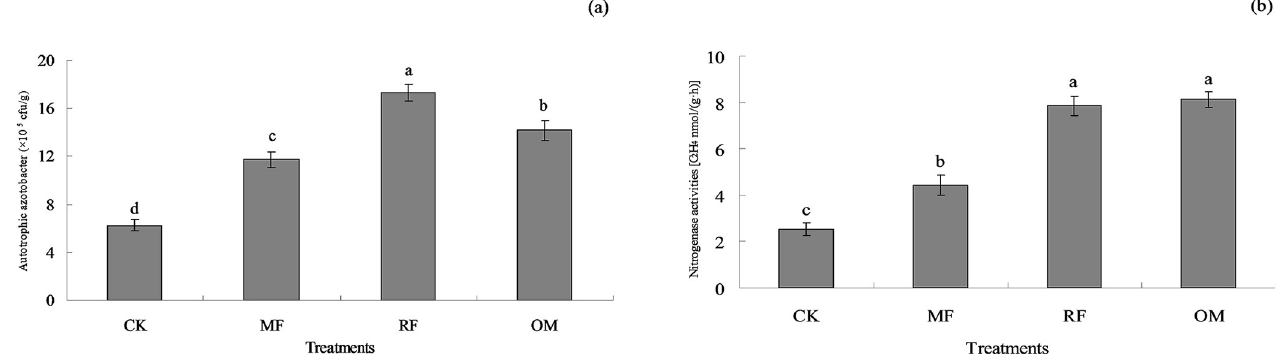
Fig 1. Effects of different long-term fertilizer treatments on soil autotrophic azotobacter (a) and soil nitrogenase activities (b). MF: Chemical fertilizer alone; RF: Rice straw residue and chemical fertilizer; OM: 30% organic manure and 70% chemical fertilizer; CK: Unfertilized as a control. Error bars were represented standard error of mean. Different lowercase letters were indicated significantly different at p < 0.05 level. The same as